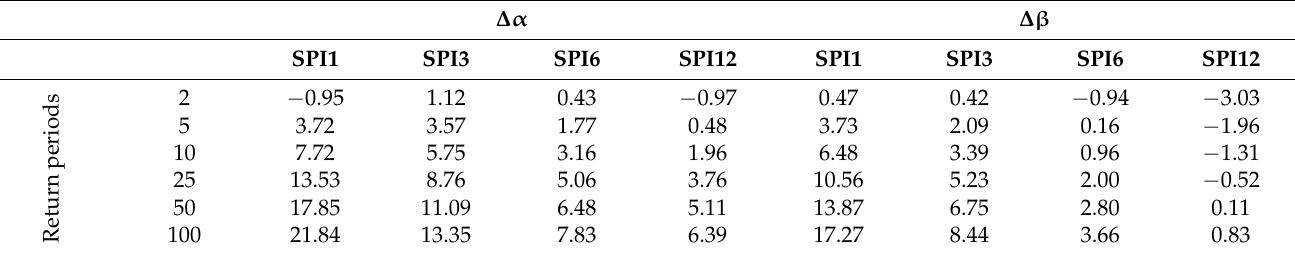
Table 7. Delta values evaluated for the two coefficients α and β of the regression lines. ∆ α ∆